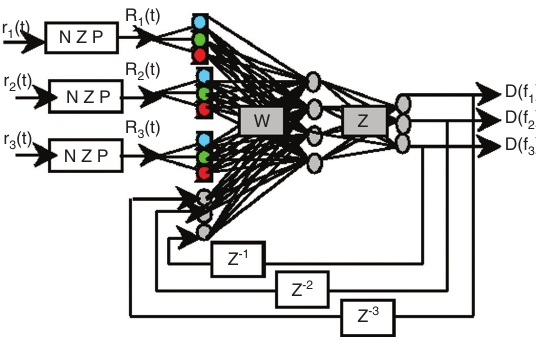
Figure 3. Example of an RNN Used for Residual